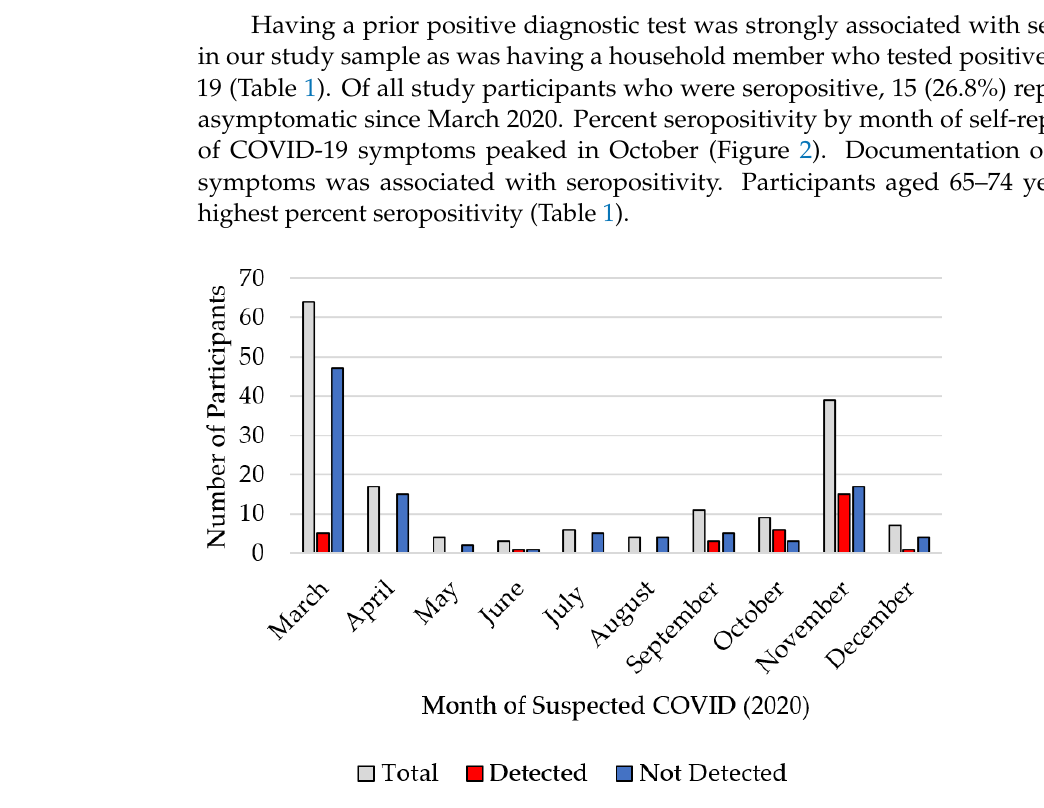
Figure 2. Number of study participants by month of suspected COVID-19 via self-reporting and serosurvey test results